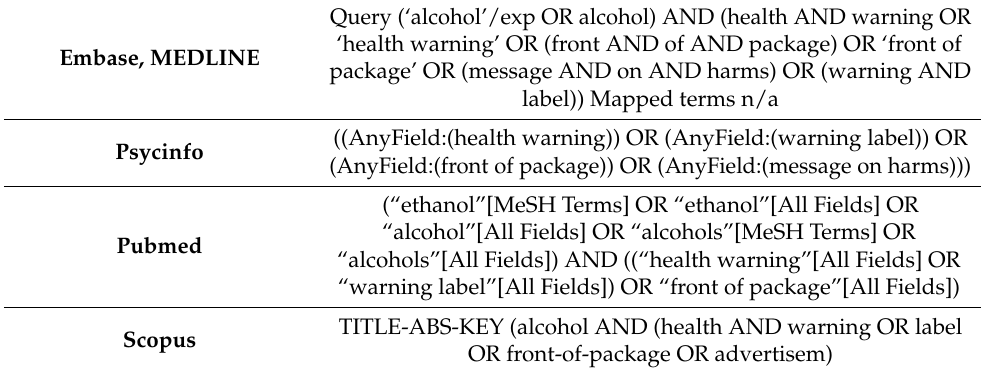
Table 1. Search Strategy. Query (‘alcohol’/exp OR alcohol) AND (health AND warning OR ‘health warning’ OR (front AND of AND package) OR ‘front of Embase, MEDLINE package’ OR (message AND on AND harms) OR (warning